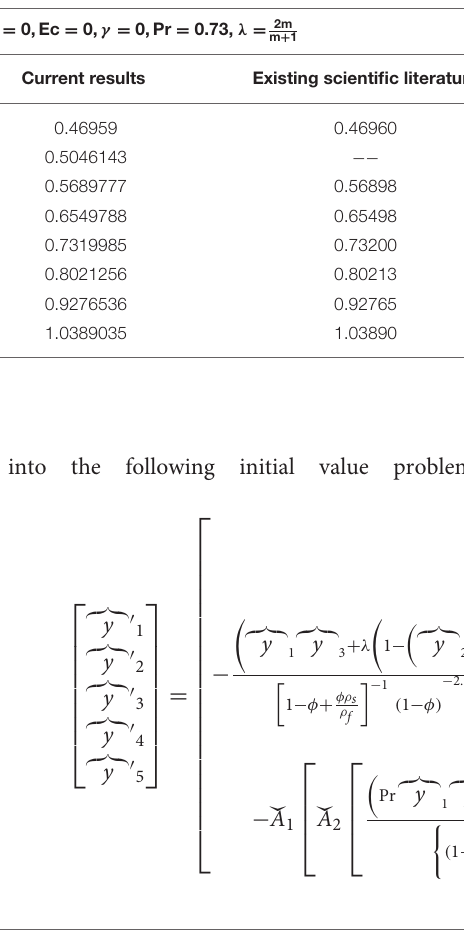
TABLE 2 | Reliability of the study by comparing with existing scientific literature for F ′′